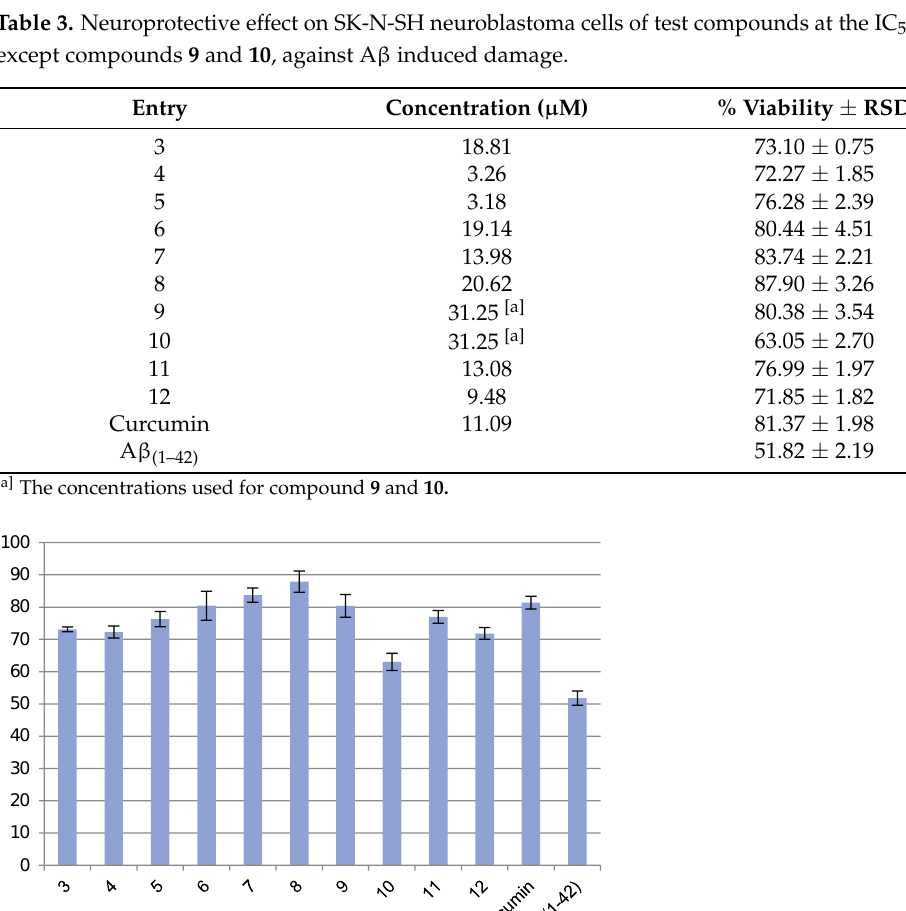
Figure 2. Neuroprotective impact on SK-N-SH neuroblastoma cells of the produced compounds at IC 50 values of antiaggregation, except compounds 9 and 10 , which were employed at the concentra- tion of 31.25 µM. The percentages of relative cell viability (mean ± RSD) were calculated at 24 h with 25 μM of Aβ 1 – 42 using MTT assays ( n = 6) (Y = %viability, X = synthesized compounds). The effect of Aβ 42 in inducing cell death was confirmed using a phase-contrast in- verted microscope. After 24 h incubation with 25 μM Aβ 42 , the cells became rounded up and detached from the plate surface, as depicted in Figure 3A, whereas the treated SK-N- SH cells with compound 5 display healthy cell bodies with neurites (Figure 3B).